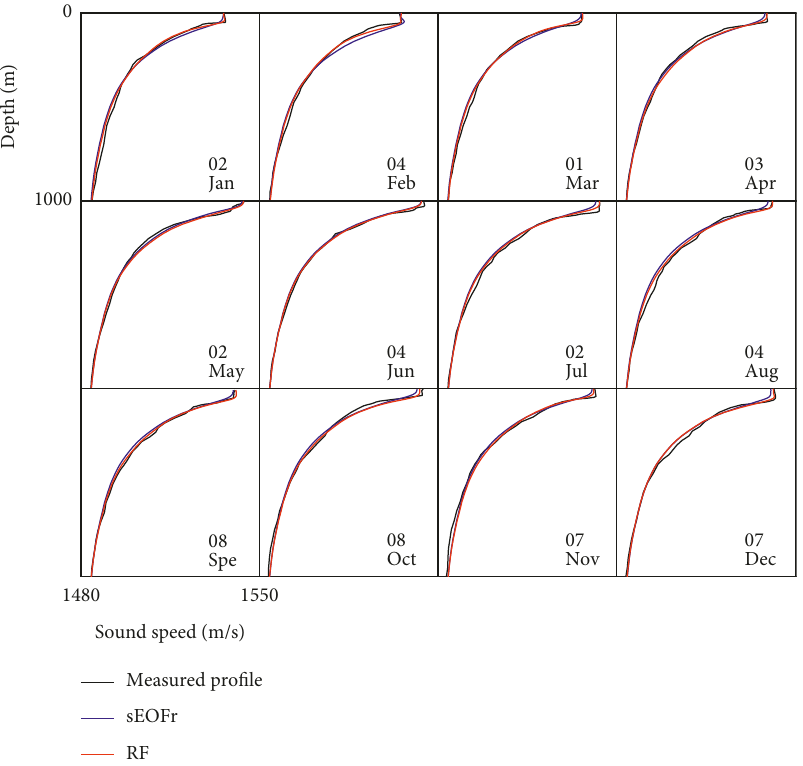
Figure 7: Reconstruction results of the first effective profile for each